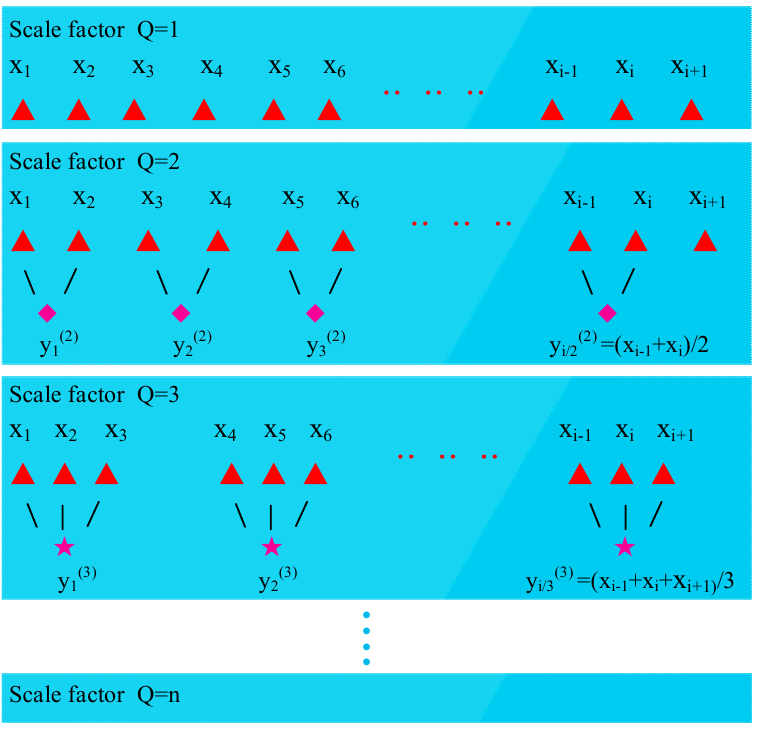
Figure 2. Coarse graining process.